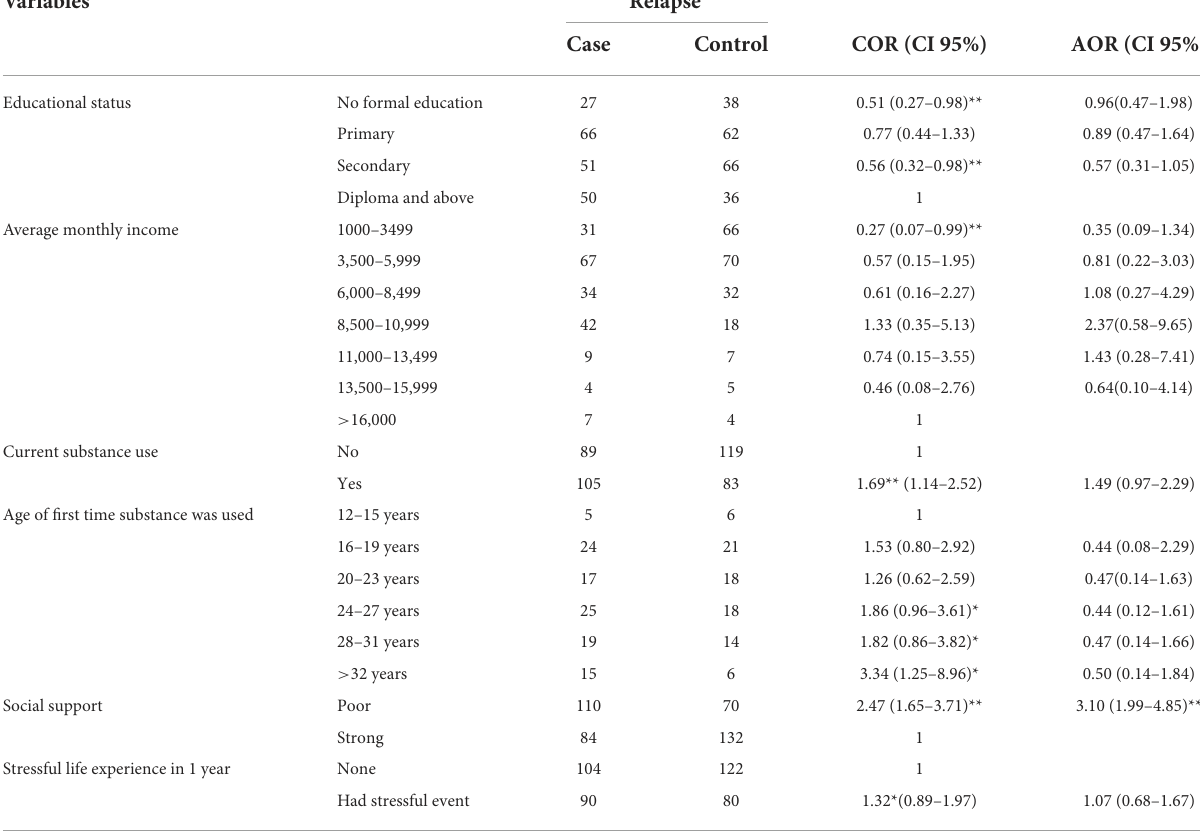
TABLE 4 Factors associated with relapse in of patients with schizophrenia at the AMSH, Addis Ababa, Ethiopia ( n = 396).